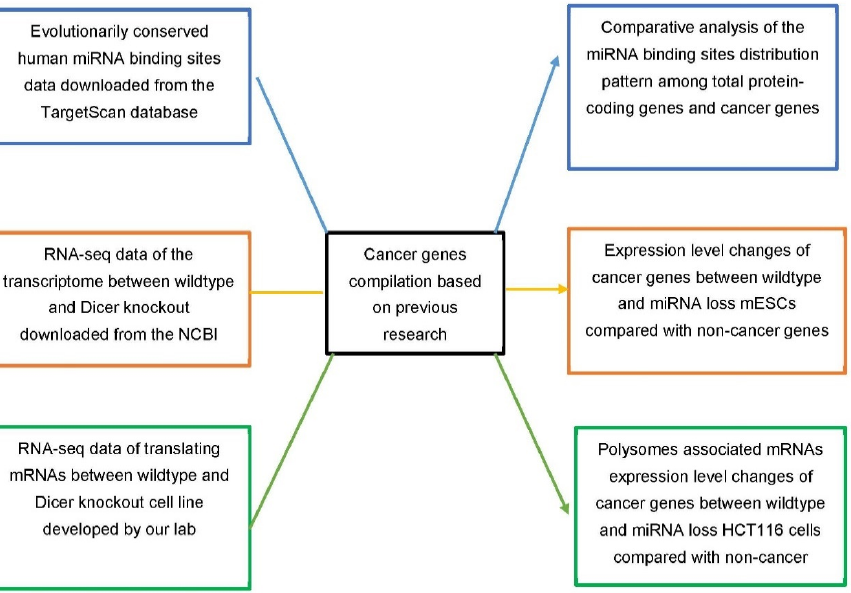
Figure 1. Schematic representation of the experimental design for the comparison of miRNA-mediated gene expression repression of oncogenes and TSGs.